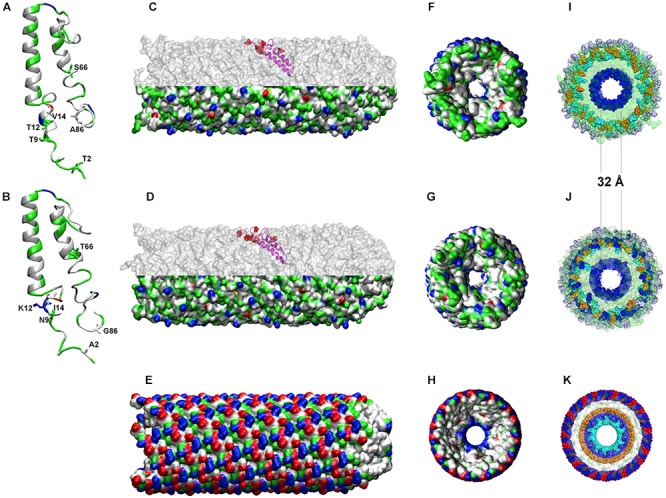
Predicted tertiary structures for TraA1 and TraA2 monomers and multimers. (A,B) Modeled TraA1 and TraA2 pilin monomers, respectively. (C,D) Modeled pilin multimers formed by TraA1 or TraA2, respectively. Upper half shows the position of one monomer in the channel. (E) 5LEG crystal-based model for S. typhi pilus. (F–H) Rear view of TraA1, TraA2, and 5LEG pilus, respectively, using van der Waals radio representation. (I–K) transversal view of the charged amino acid residues distribution of the three pili under comparison as above. The colors indicate the physicochemical properties as follows: blue, positive residues (Arg, cyan; Lys, blue; His, purple); red, negative residues (Asp, red; Glu, orange); green, polar residues and white, non-polar residues.